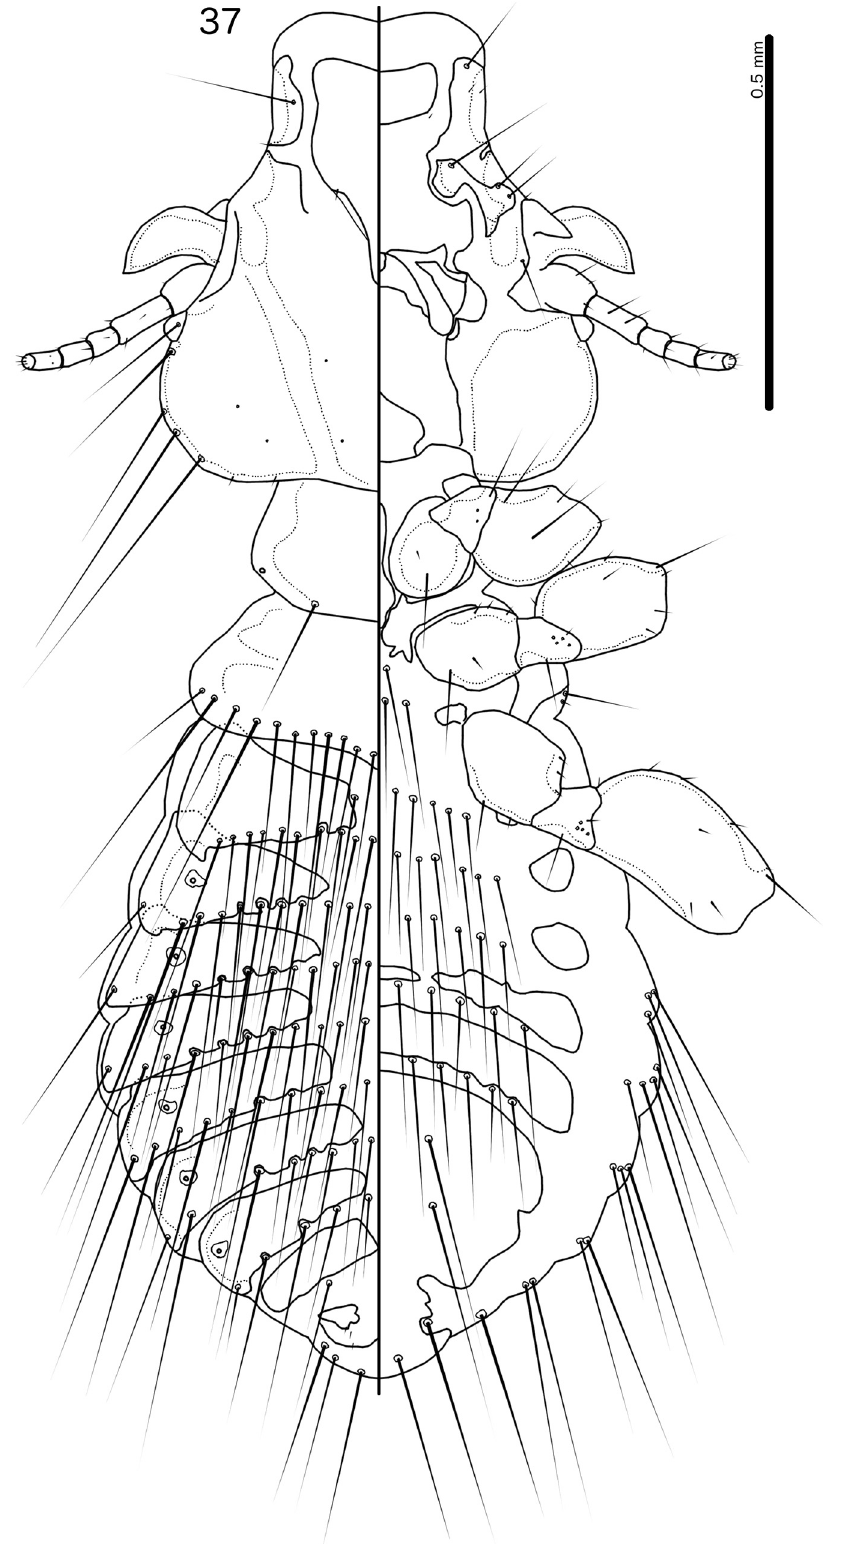
Fig. 37. Philopterus coriaceus sp. nov. ex Molothrus oryzivorus oryzivorus (Gmelin, 1788), male habitus, dorsal and ventral